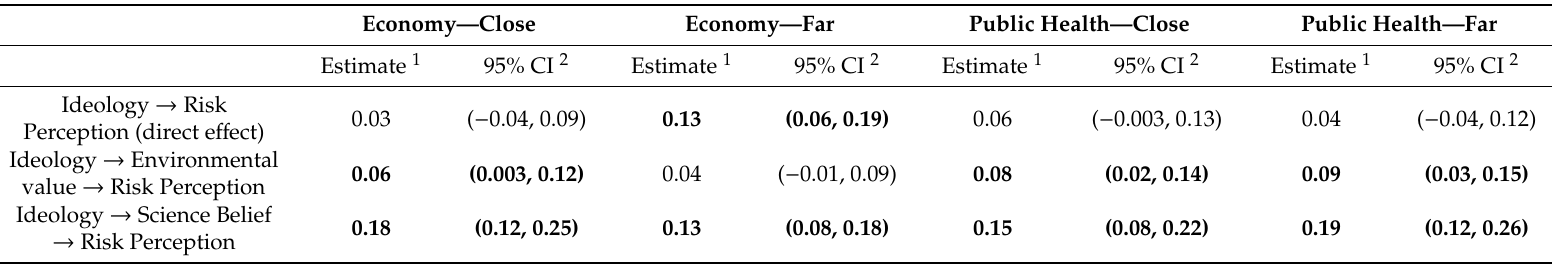
Table 4. Direct and indirect e ff ects of ideology on risk perception in four experimental conditions (unstandardized regression coe ffi cients). Economy—Close Economy—Far Public Health—Close Public Health—Far